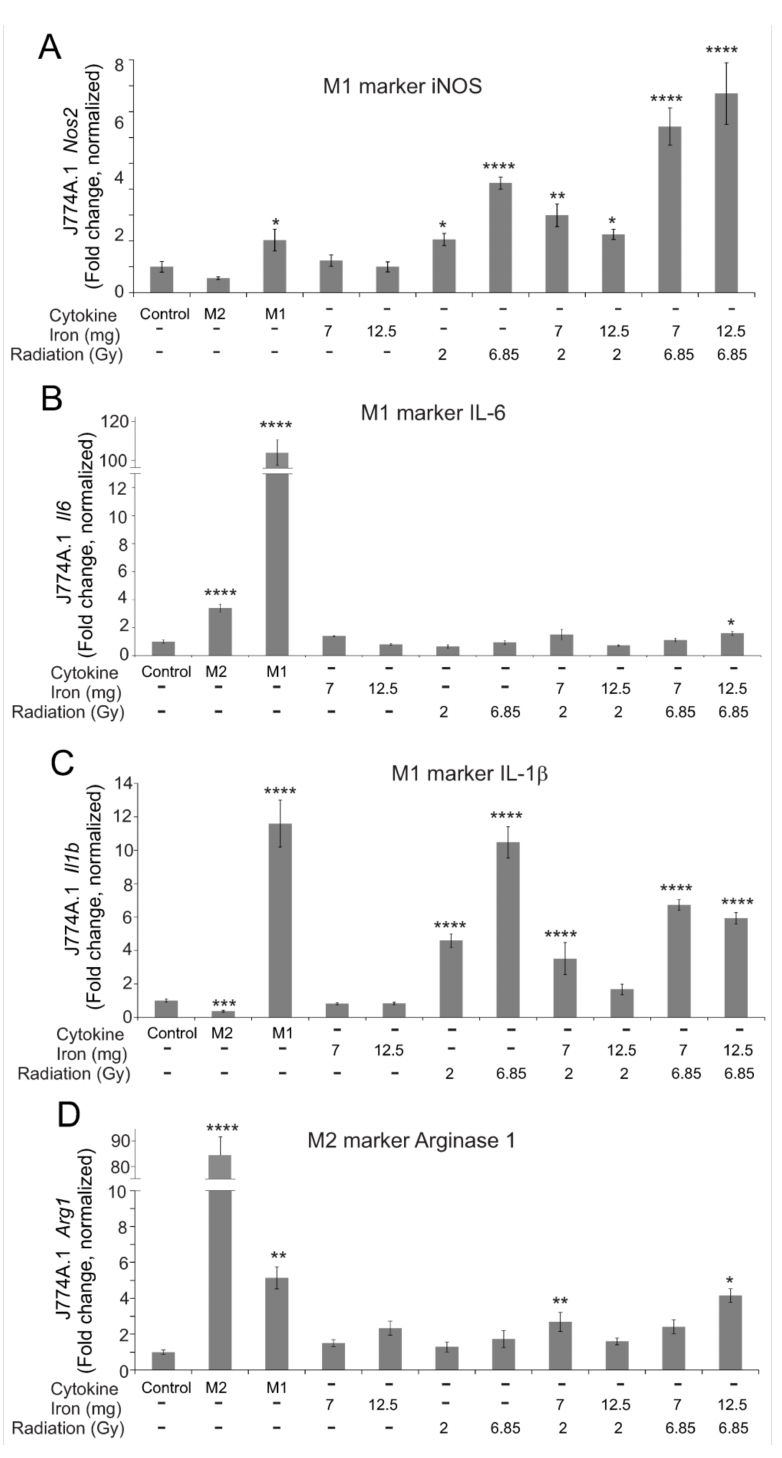
Figure 9. Effects of radiation and high iron concentrations on J774A.1 murine macrophage polar- ity in culture. J774A.1 cells were grown to ~80% confluence, and untreated (control) exposed to either 7 or 12 mg/L Fe 3+ and/or 2 or 6.85 Gy X-ray irradiation. As a control for M2 polarization, cells were treated with 100 ng/mL IL-4; as a control for M1 polarization, cells were treated with 100 ng/mL IFN- γ + 100 ng/mL LPS. 24 h post-irradiation, RNA was purified. qPCR was performed for M1 markers ( Nos2 ( A ), Il6 ( B ), and Il1b ( C )), and an M2 marker ( Arg1 ( D )). Gene expression was normalized to Gapdh, and fold increase was calculated relative to untreated cells (control). Graphs show means ± SEM, n = 3 independent experiments. Asterisks: * indicates p < 0.05 from control levels; ** indicates p < 0.01 from control; *** indicates p < 0.001 from control; and **** indicates p < 0.0001 from